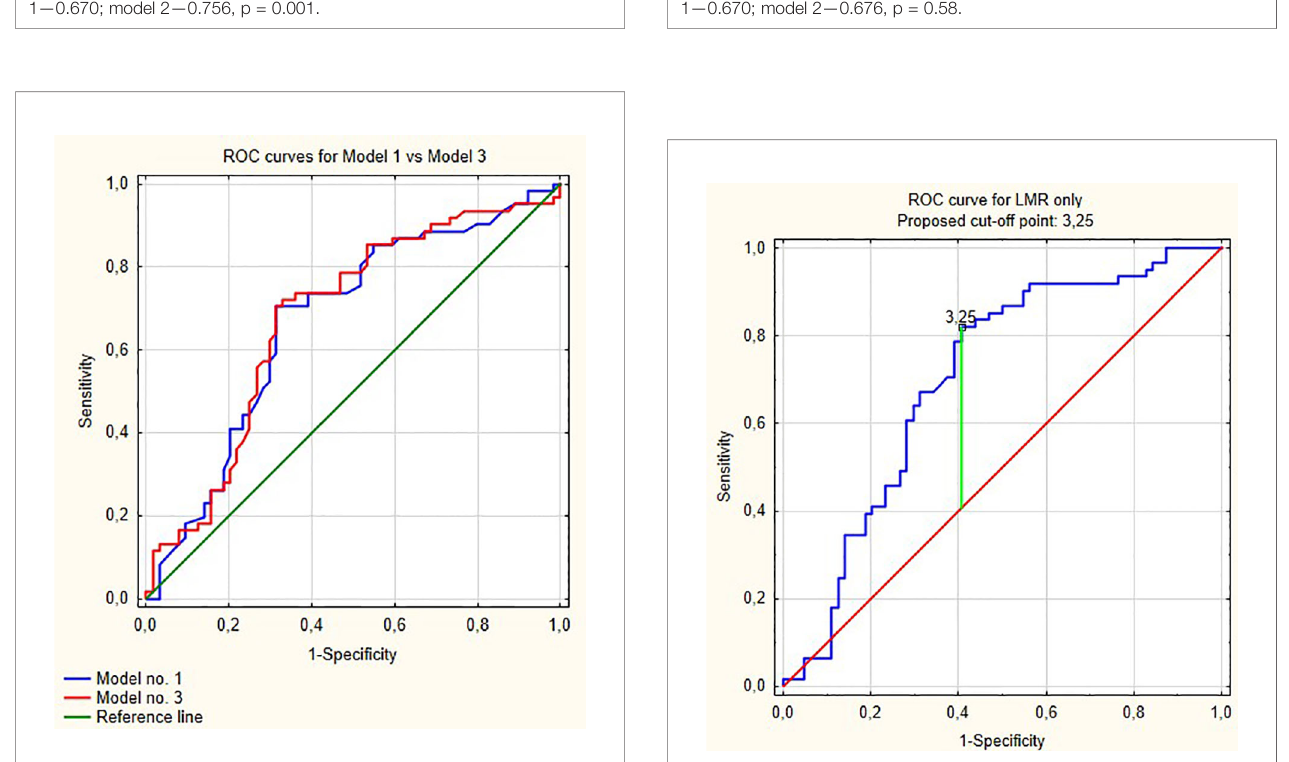
FIGURE 2 | Comparisons of ROC curves for models 1 and 3. AUC for model 1 — 0.67; model 2 — 0.677, p = 0.53.